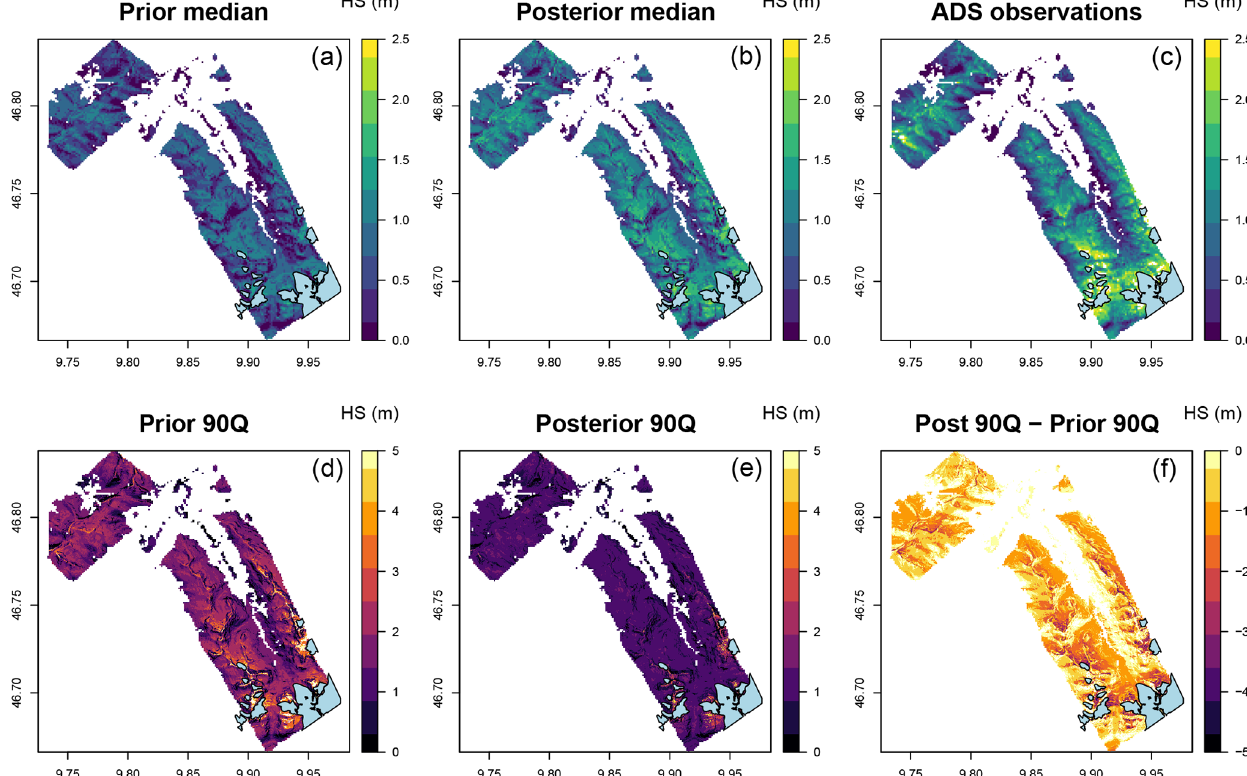
Figure 6. (a–c) Prior/posterior median and observations from ADS sensor flights in the Davos region on 14 April 2014 (see Fig. 2 for location). (d–f) Uncertainty represented by the 90th percentile range of the ensemble and the reduction in the uncertainty in the posterior. The glacier mask is shown in blue. The posterior median is improved with respect to the observations, and the uncertainty is reduced by the DA scheme.